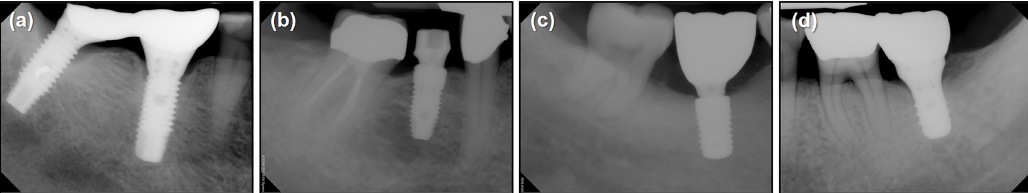
Figure 1. Periapical radiographs of the four types of selected implants. ( a ) Brånemark Mk TiUnite, ( b ) Dentium Implantium, ( c ) Straumann Bone Level, and ( d ) Straumann Tissue Level